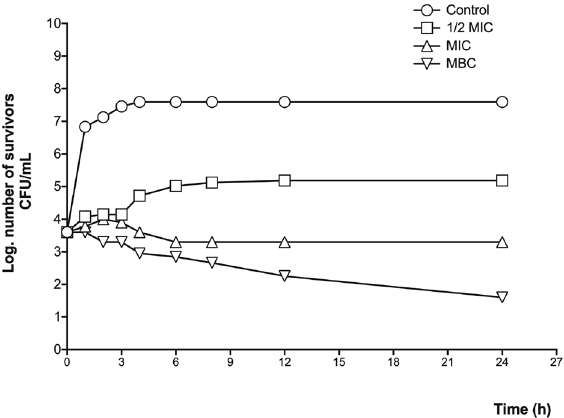
Figure 4. Time-killing bacterial kinetic assay of the methanolic leaf extract against the E. coli clinical case. 1/2MIC = 0.31 mg/mL; MIC = 0.62 mg/mL; MBC = 1.25 mg/mL.